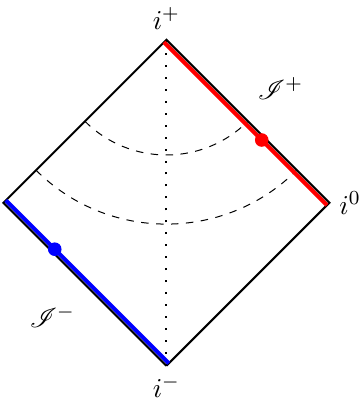
Figure 1 . When the saddle-point approximation is valid, the boundary operators correspond to operators inserted on I ± . For the momentum and celestial bases they are smeared along the null generators, as illustrated by the antipodally placed blue (past) and red (future) contours. The celestial basis views scattering in terms of constant-Rindler time cuts [15] (dotted), in contrast to the constant- u cuts considered in [44]